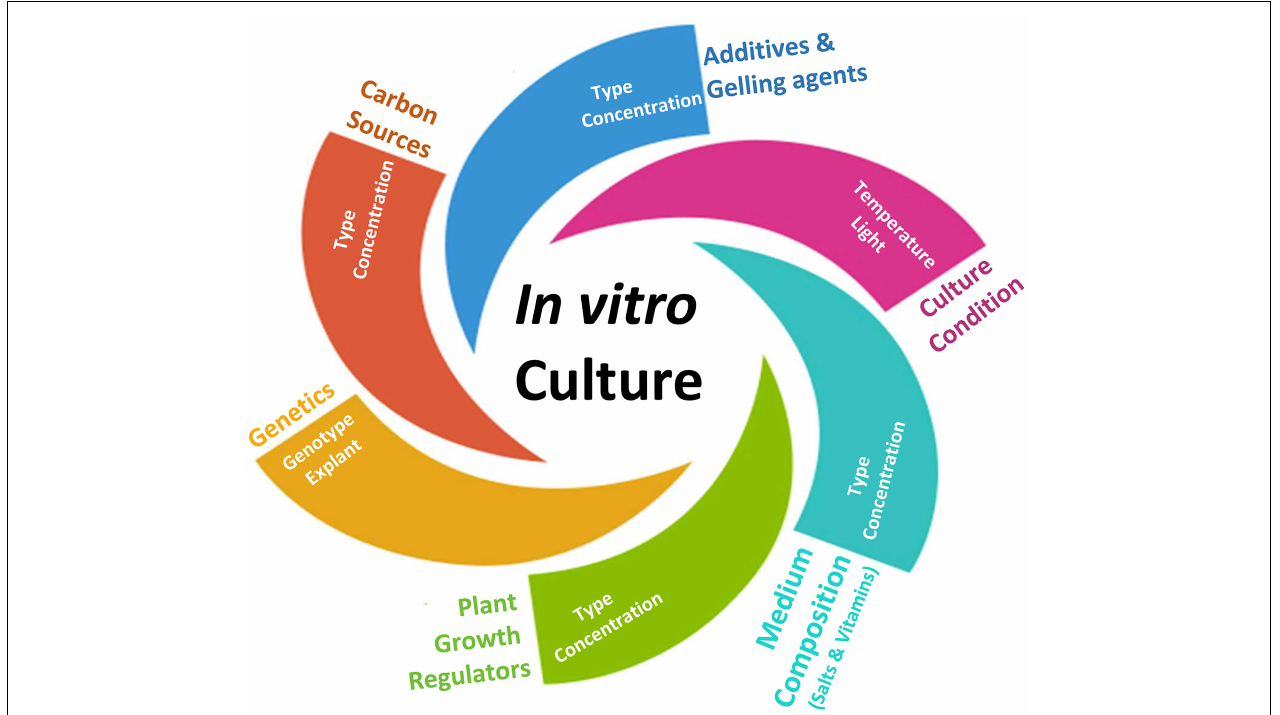
FIGURE 1 | A schematic representation of factors influencing in vitro